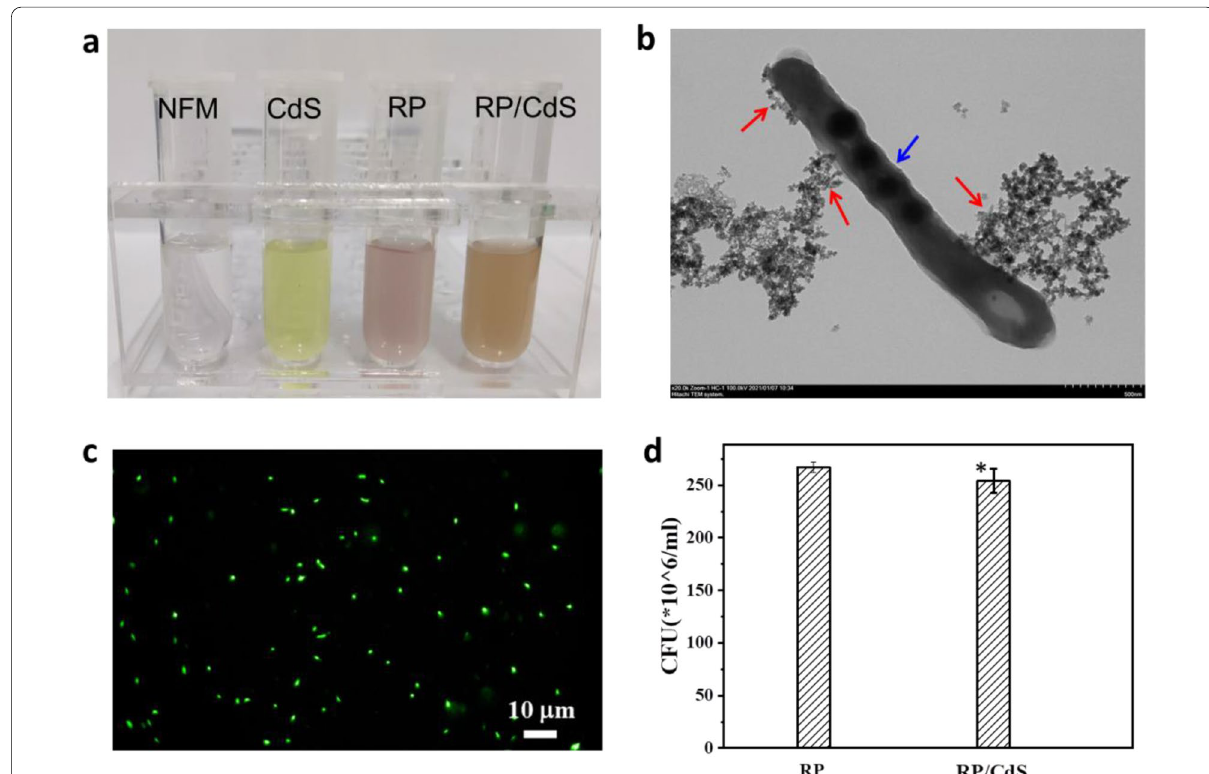
Fig.1 Assembly of RP/CdS bio‑nano‑hybrid cells. a The photographs of NFM medium, CdS QDs, RP cells suspension and RP/CdS hybrid cells suspension. b TEM image of the RP/CdS bio‑nano‑hybrid cells. Red arrows indicate the nanoparticles, blue arrow indicates the RP cell. c Fluorescence image of RP/CdS bio‑nano‑hybrid cell stained with LIVE‑DEAD Baclight kit. Green fluorescence indicates living cell. d Colony formation unit of RP and RP/ CdS bio‑nano‑hybrid cells. Statistical significance of differences was analyzed by t ‑test, * p > 0.1 (RP/CdS vs.